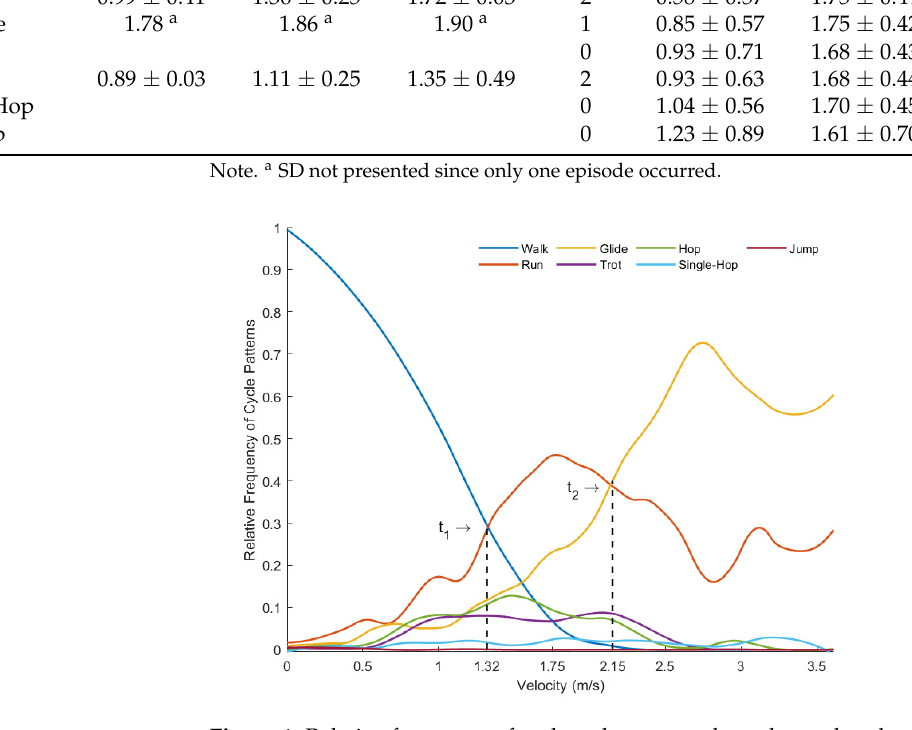
Figure 1. Relative frequency of each cycle pattern along the explored velocities and threshold points (t1 and t2) that indicate a shift in the prevalent cycle pattern.